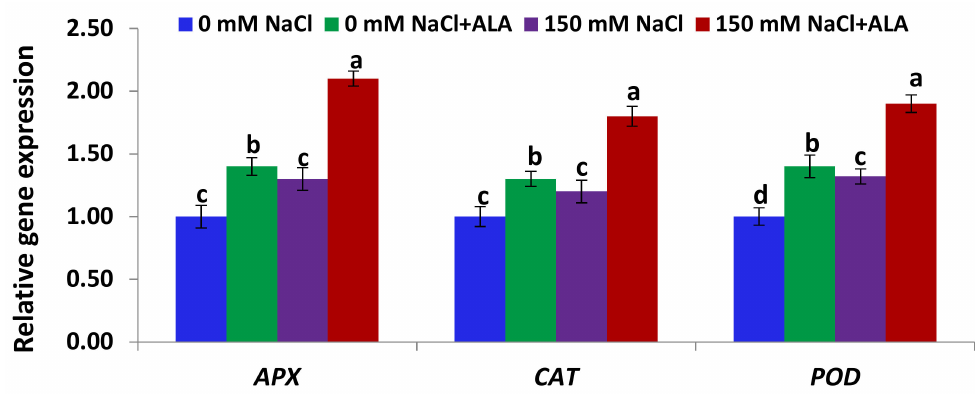
Figure 7. Expression levels of APX , CAT , and POD genes in leaves of the Elatius 3 cultivar following salinity (150 mM NaCl) and 5-aminolevulinic acid ([ALA], 6 ppm) treatments. Data are means ± SE ( n = 4). Different letters indicate significant differences between treatments ( p ≤